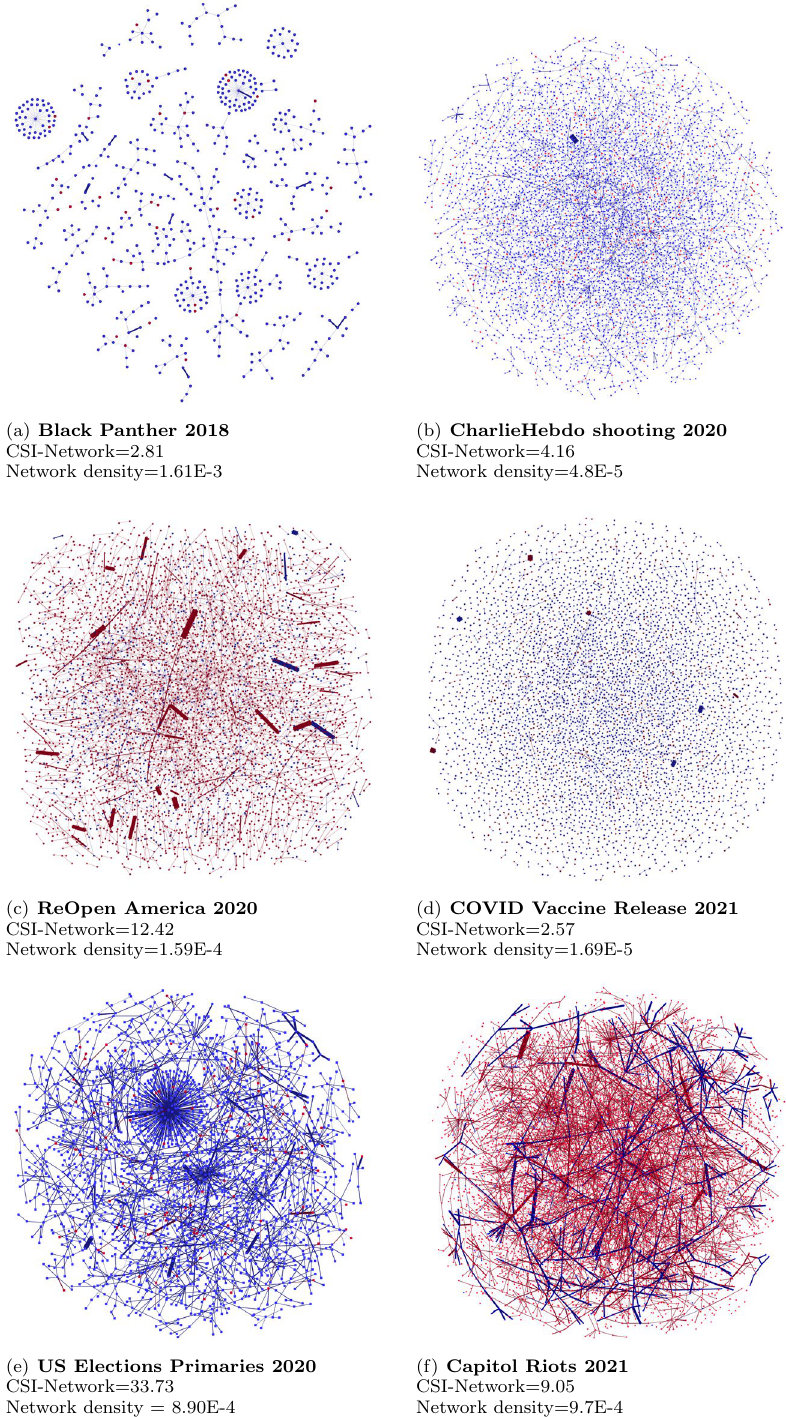
Fig. 4 Synchronized network graphs. Nodes are users. Red nodes are bots and blue nodes are humans. Links two users represent synchronization between them. Link widths represent the degree of synchronization. Graphs have been pruned to show nodes that synchronize with at least 5 different users to depict only the core structure of users that synchronize very